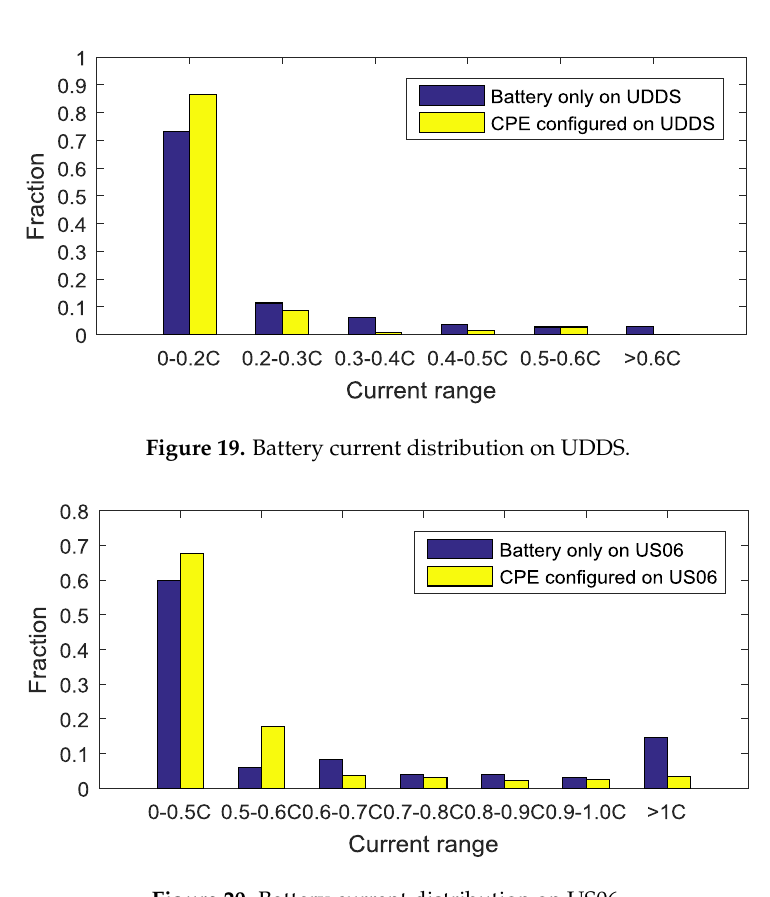
Figure 18. Battery current on US06.